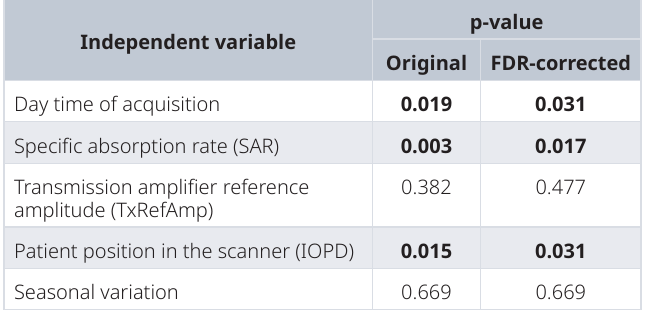
Table 2. Independent variables’ original and corrected p-values from the model in Figure 2. FDR, false discovery rate.